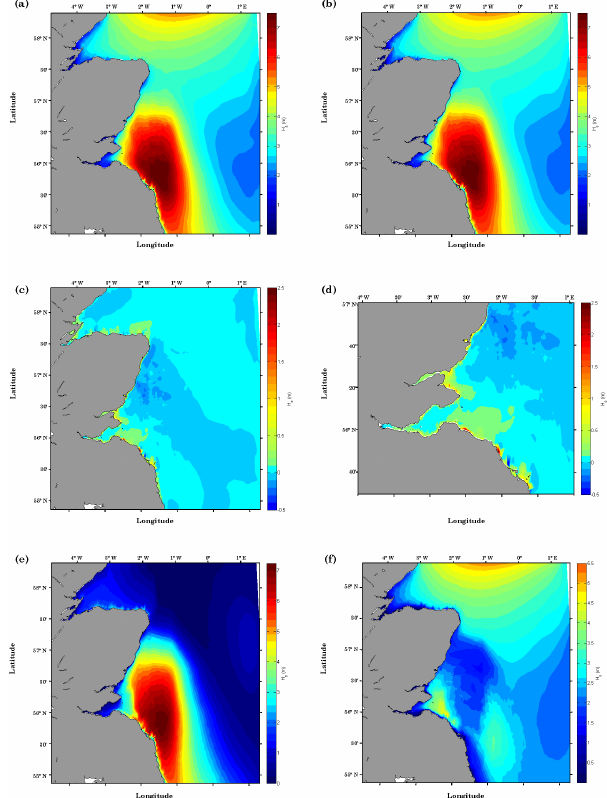
Figure 15. The modelled H s on the east coast of Scotland at 02:00UTC on 31 March 2010: (a) coupled model (mean WCI in- cluded), (b) uncoupled model (mean WCI not included), (c) dif- ference between coupled and uncoupled models, (d) difference be- tween coupled and uncoupled models in the Firth of Forth area, (e) windsea waves, (f) swell